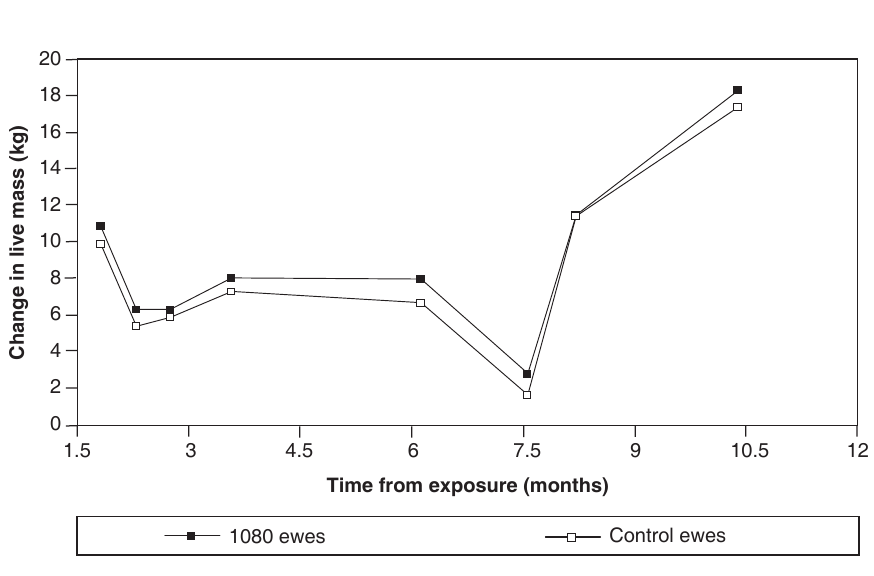
FIG. 4 Proteinaceous fluid (arrow) and polymorphonuclear leukocytes (arrowhead) in alveoli and bronchioles, with mixed inflammatory cell interstitial infiltrates in lungs of a sheep in Experiment 1 that died at 24 h following 1080 exposure (H & E). Bar = 25 μ m FIG. 5 Diffuse pulmonary oedema and congestion in lungs of a sheep in Experiment 1 that died at 22 h following 1080 exposure (H & E). Bar = 250 μ m FIG. 6 Focal myofibre necrosis (arrow) and inflammatory cell accumulation in heart of a sheep in Experiment 2 that died at 21 h following 1080 exposure (H & E). Bar = 25 μ